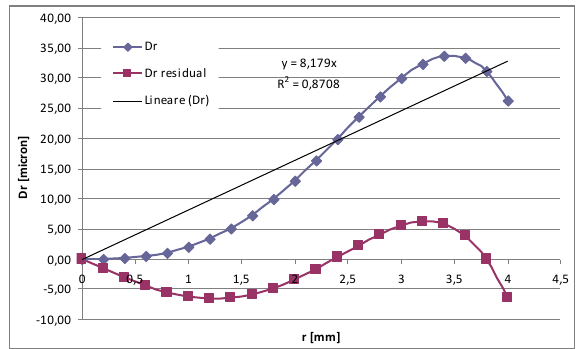
Figure 4 - Radial lens distortion resulting from Samsung S5 calibration